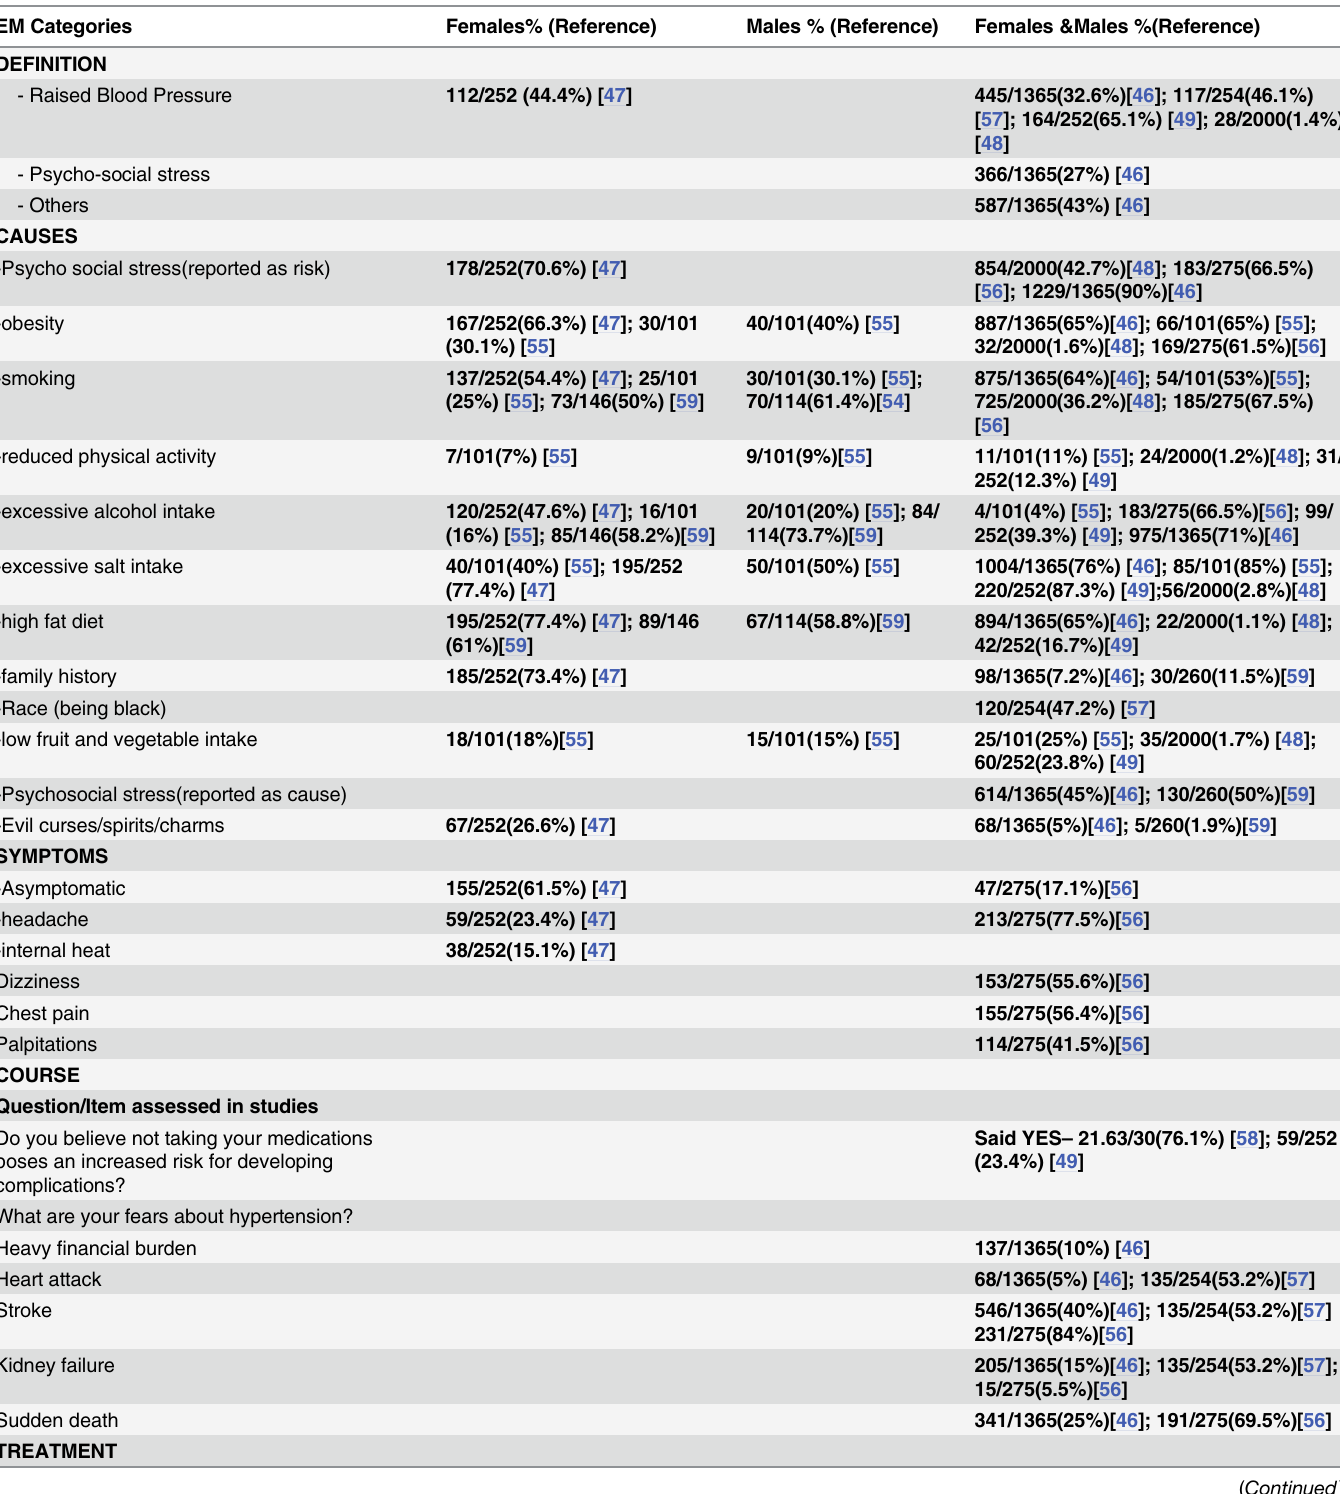
Table 3. Proportion of Lay persons with respective beliefs under EM categories: “ definition ” , “ cause ” , “ Course ” , “ symptoms ” & ” treatment ” in quantitative